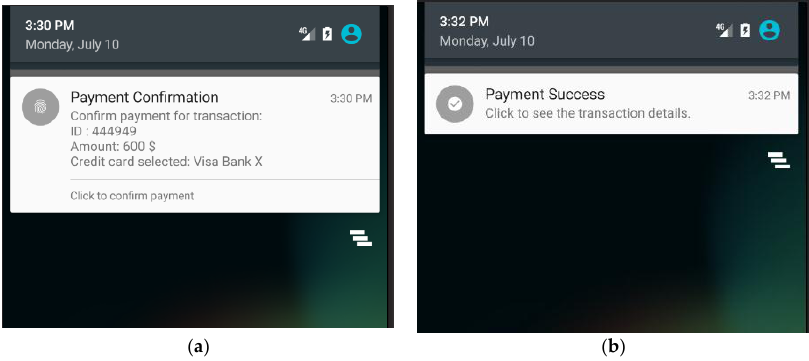
Figure 10. The screenshots of the payment App: ( a ) the payment App receives a payment- confirmation message sent from the POS terminal; and ( b ) the payment App has successfully processed the payment transaction.